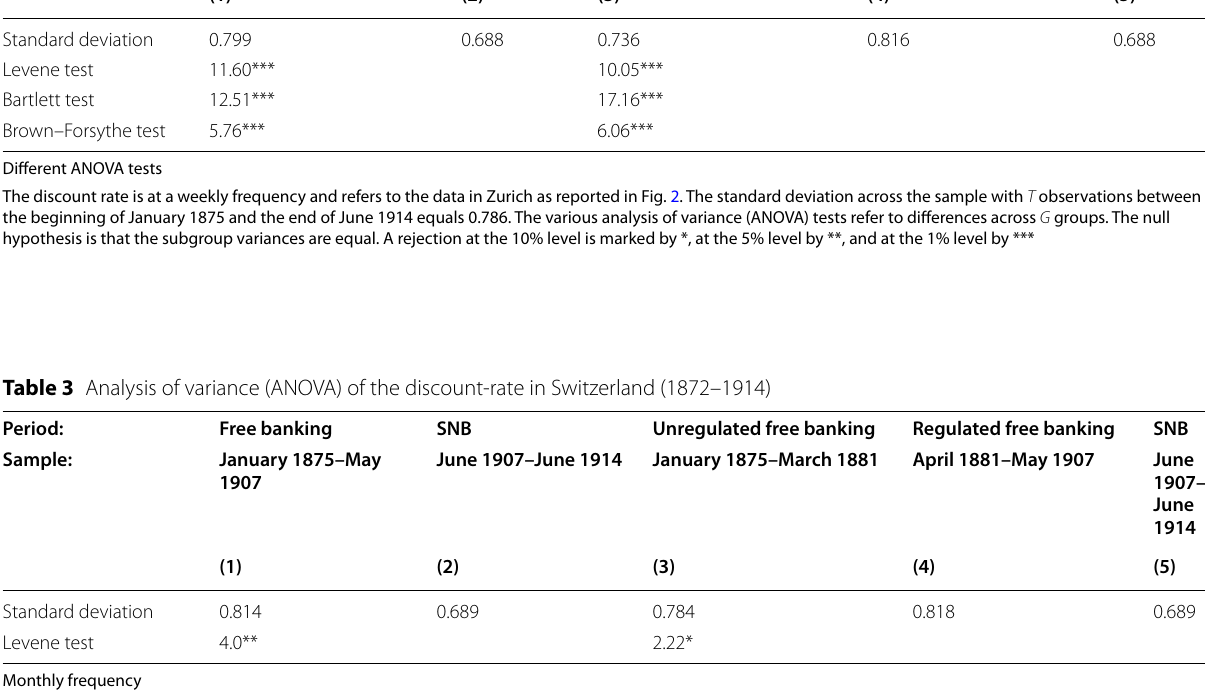
Monthly frequency